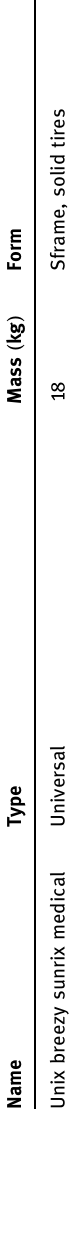
Figure 4: Amplitude – frequency characteristics of the passage of able - bodied people in a universal wheelchair ( active and passive run ) and of a disabled person in an active wheelchair; runs on the surface of the granite cube type, direction “ Z . ”